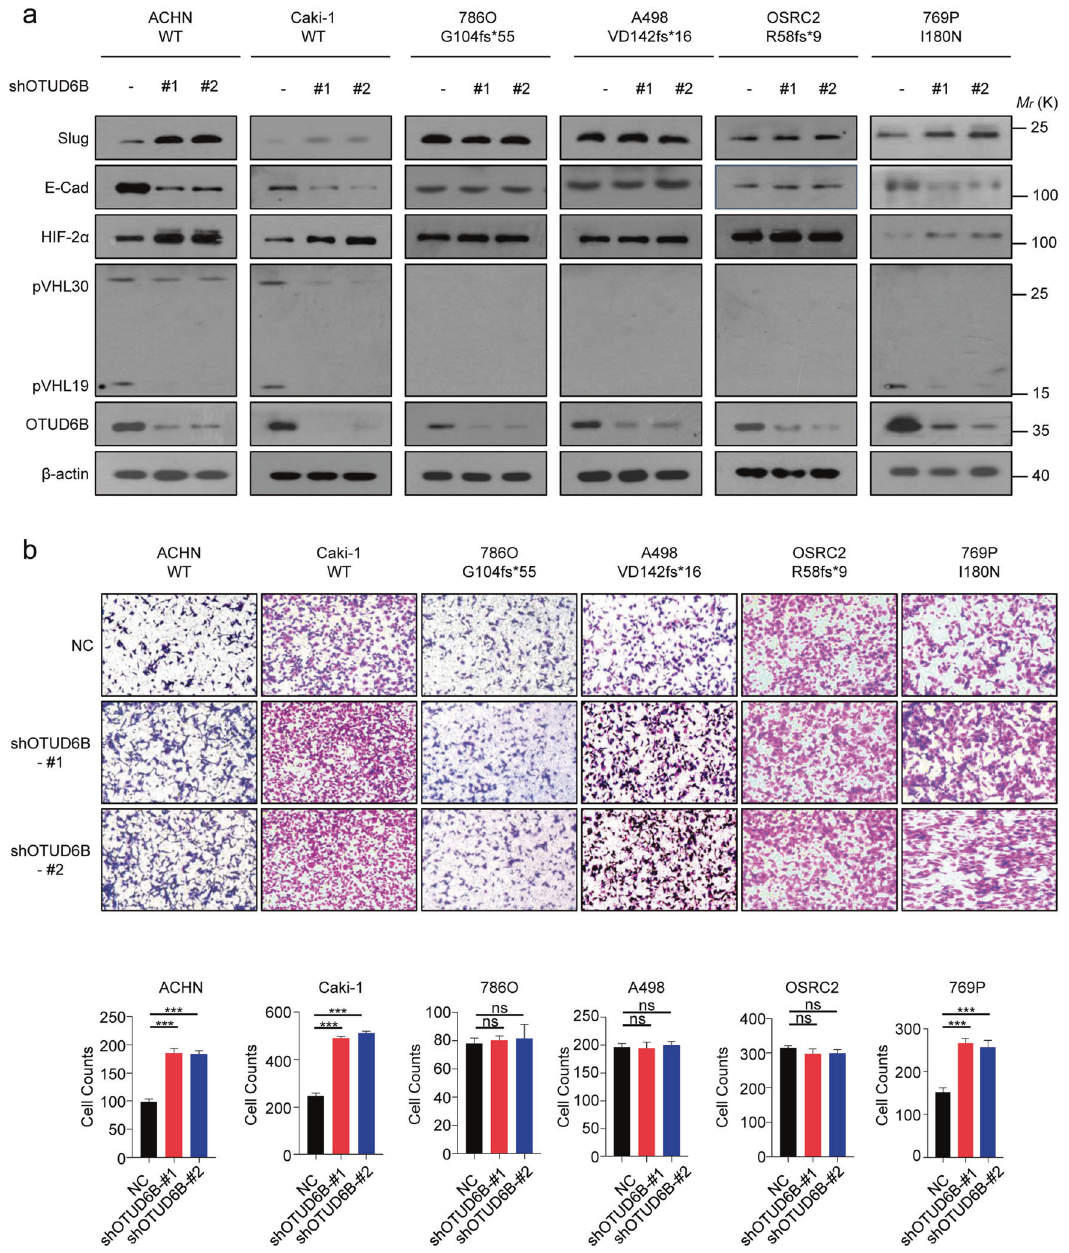
Fig. 2 OTUD6B enhances pVHL level and inactivates HIF pathway. a The lentivirus with shRNA targeting OTUD6B were each infected into ACHN, Caki-1, 786-O, A498, OSRC2, and 769P cell lines, generating ccRCC cells with OTUD6B stable knockdown. Immunoblot assays were conducted with indicated antibodies in ccRCC cell lines with or without OTUD6B stable knockdown. b Transwell assay was conducted to examine cell migration in ACHN, Caki-1, 786-O, A498, OSRC2, and 769P cells with OTUD6B knockdown or negative control (NC). Cell counts were shown in histogram. Results are displayed as mean ± s.d. n = 3 independent experiments. *** P < 0.001, Student ’ s t